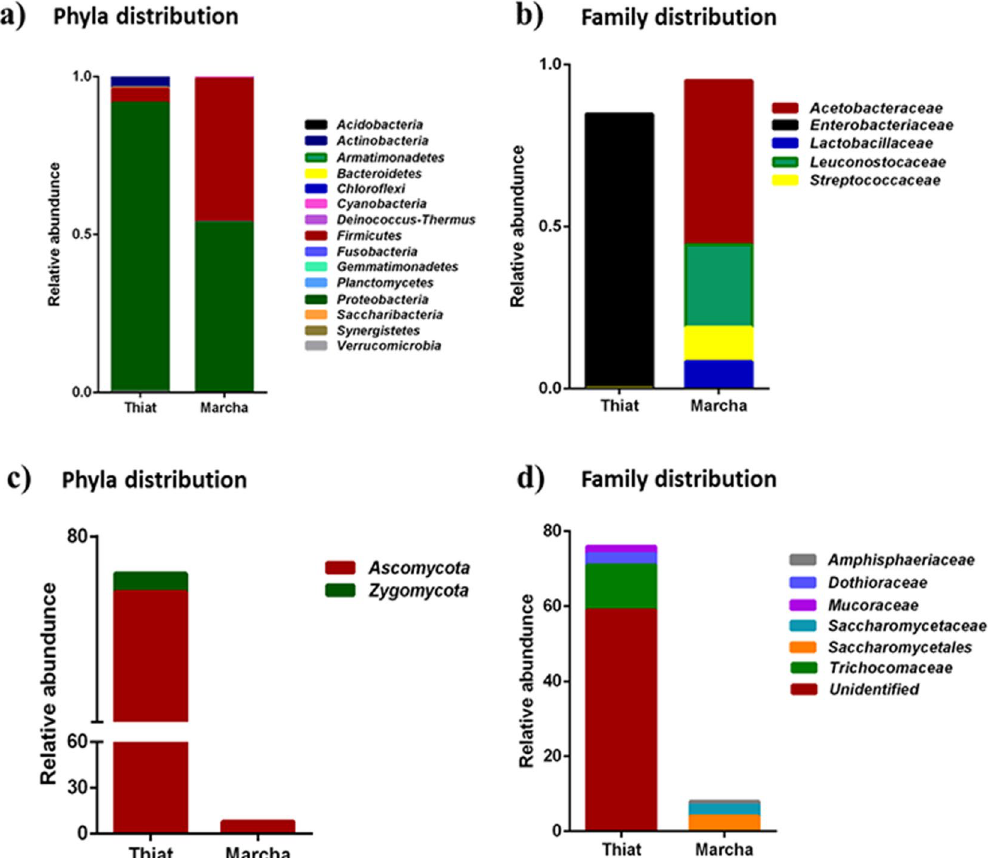
Figure 2. Taxa distributions of phylum and family at different phylogenetic level in thiat and marcha . ( a ) bacterial phyla; ( b ) bacterial family; ( c ), fungal phyla and ( d ) fungal